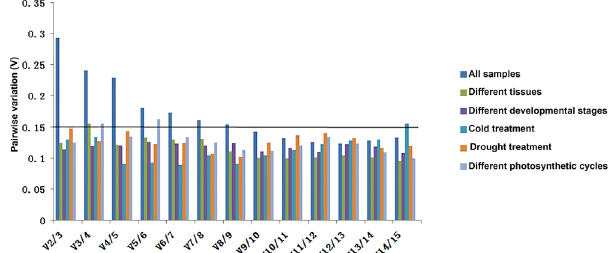
Figure 3. Determination of the optimal number of reference genes for normalization in the tested experimental conditions. geNorm was used to calculate the normalization factor (NF) from at least two genes; the variable V defines the pair-wise variation between two sequential NF